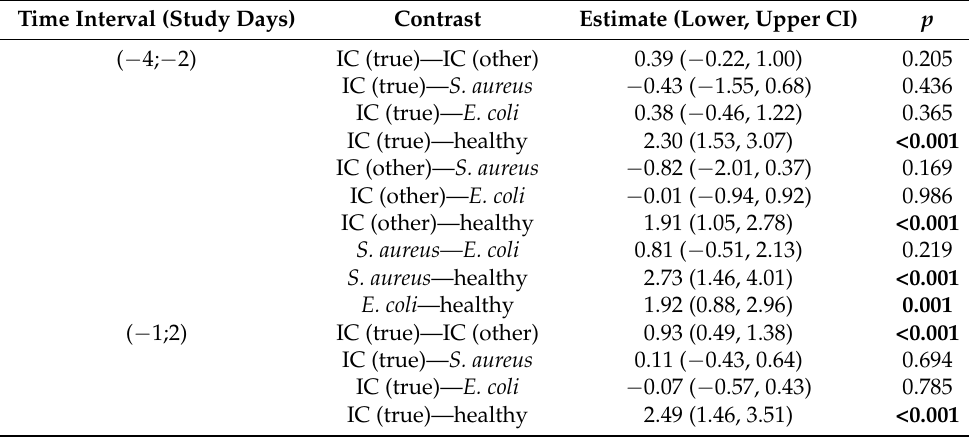
Table A2. Differences in interleukin 17A levels between study groups per time interval for the total study